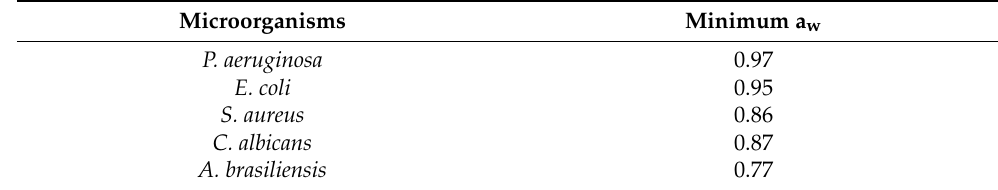
Table 5. Minimum a w values for the growth of pathogenic germs in cosmetics